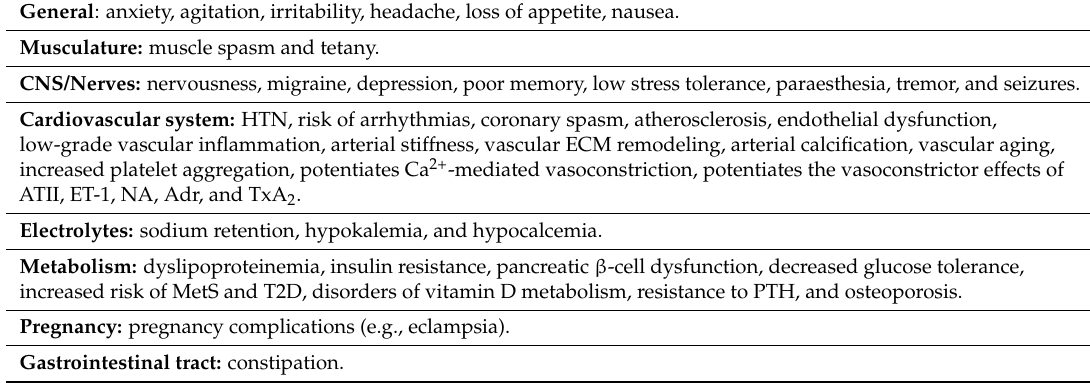
Table 1. Negative effects of MgD on the body and